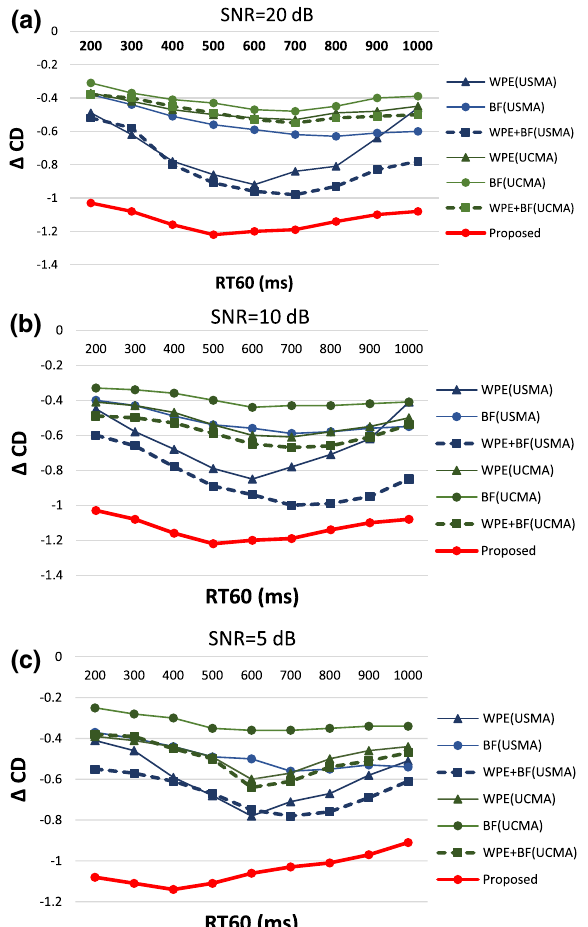
Fig. 9 (cid:31) CD changes in proportion to RT60 for beamforming (BF), dereverberation (WPE) and their combination (WPE BF) with the USMA and the UCMA geometries in comparison to the proposed + approach in three noise levels